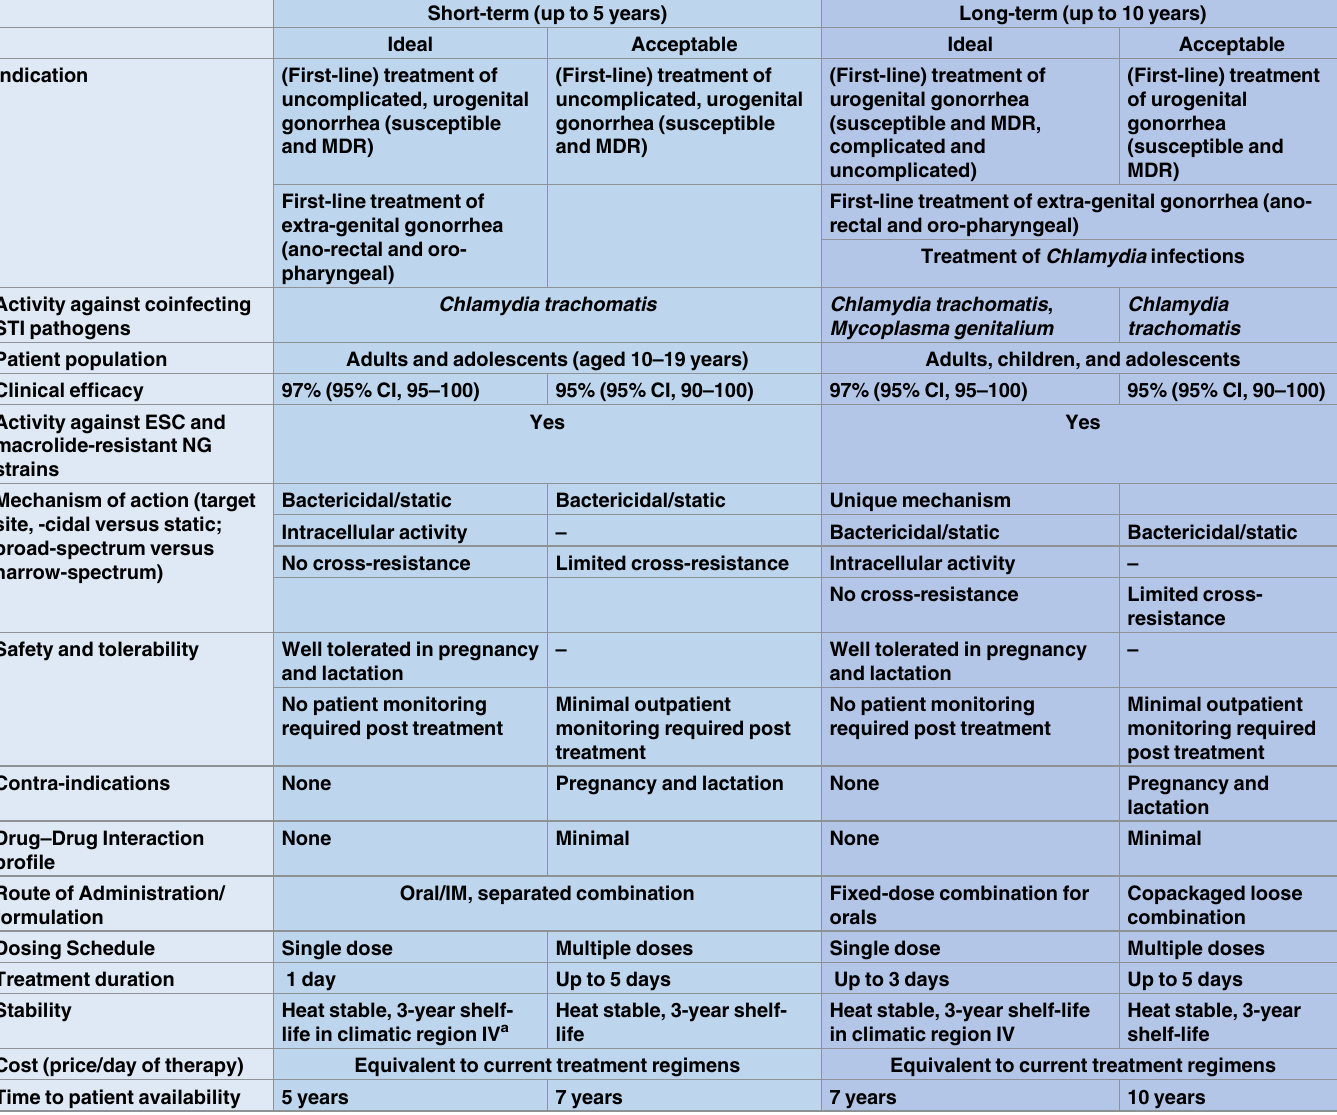
Component 2: Evaluate the potential of existing antibiotics and their combinations